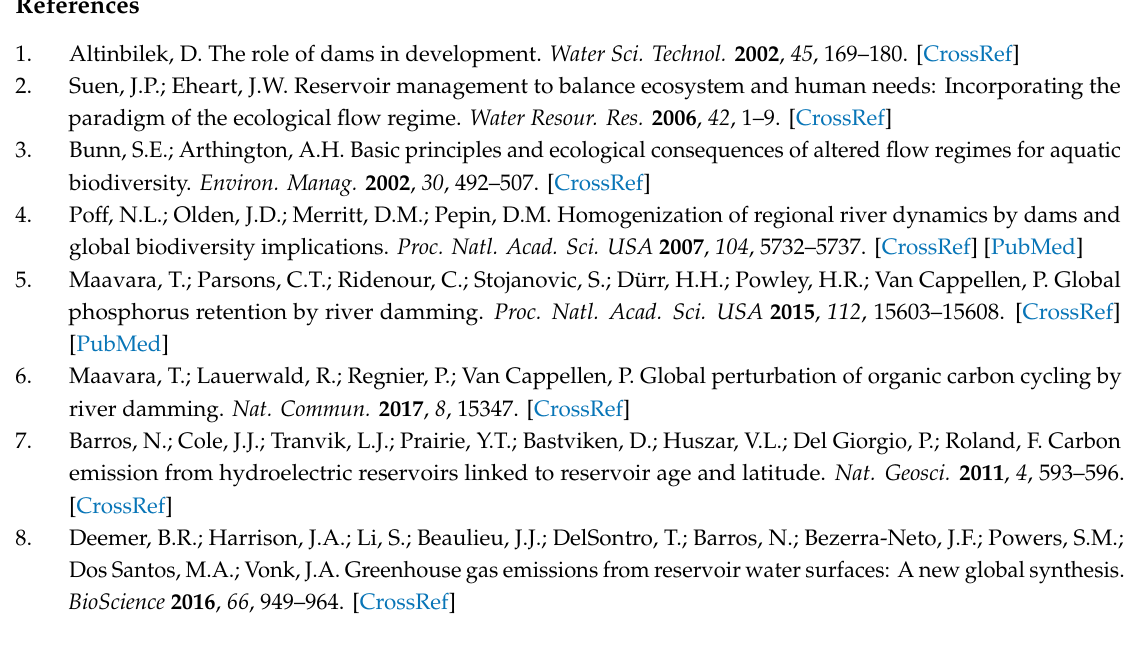
Figure S1: Grid geometry of the representation of Xiluodu and Xiangjiaba reservoir in the CE-QUAL-W2 model; Figure S2: (a) Daily mean air temperature and (b) wind speed at SJWS and YSWS meteorological station; Figure S3: Measured inflow, outflow, and water level in Xiluodu reservoir (a) and Xiangjiaba reservoir (b) in 2014–2015; Figure S4: Observed and simulated water level in front of Xiluodu (a) and Xiangjiaba (b) dam; Figure S5: Simulated and observed vertical temperature profiles in Xiangjiaba reservoir (left) and Xiluodu reservoir (right); Figure S6: (a) Discharge measures at PSGS in 1980–2011 and XJBGS in 2012–2016 (x-axis) and HTGS in 1980–2016 (y-axis); (b) Correlation between annual mean precipitation in Jinsha Basin and discharge at the downstream gauging station; Table S1: Summary of hydrological and meteorological data used in this study; Table S2: List of the meteorological stations used in the Jinsha Basin; Table S3: Main hydraulic coe ffi cients in di ff erent